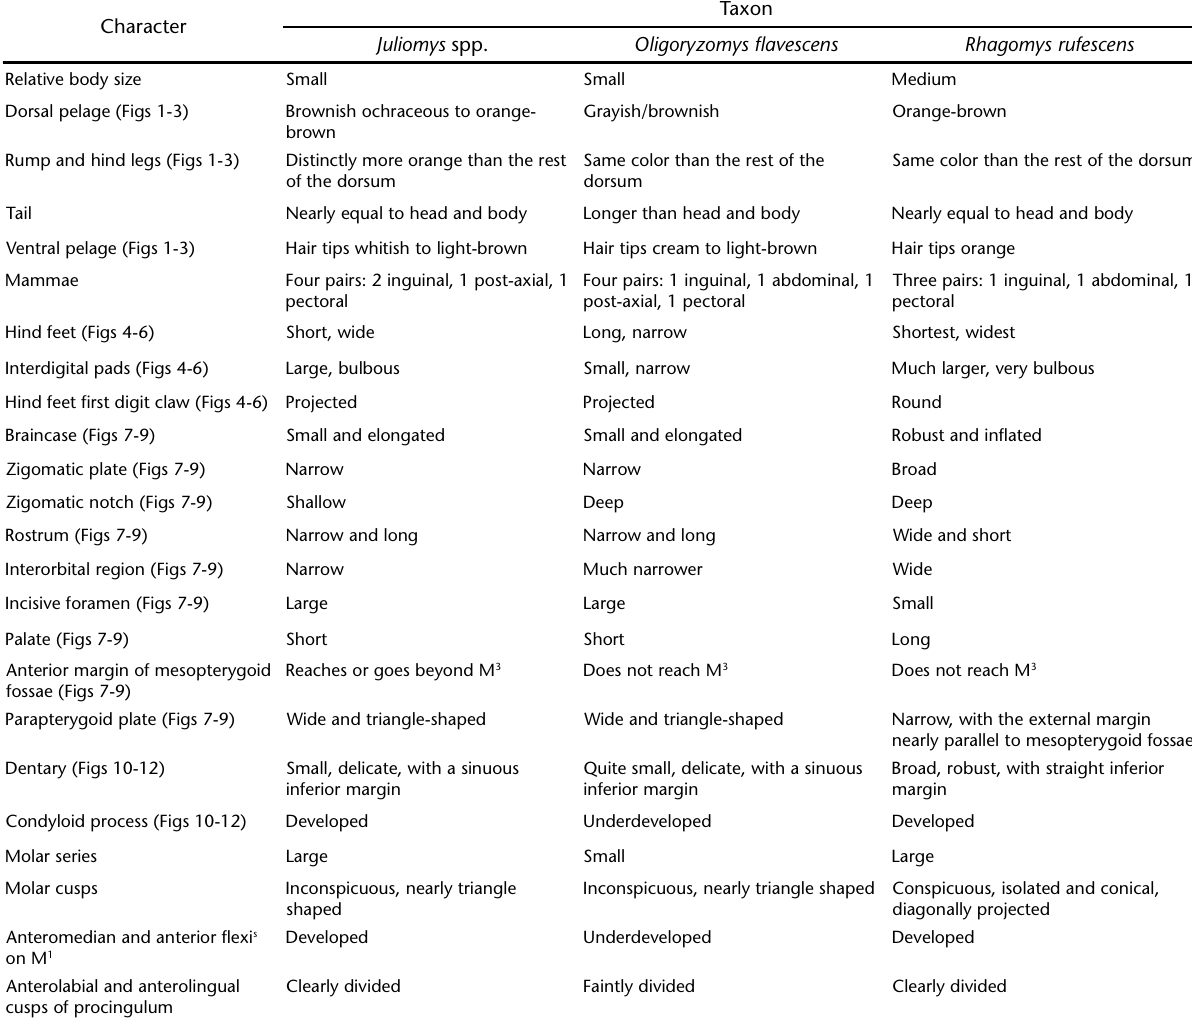
Table I. Selected comparative diagnostic characters of Juliomys spp., Oligoryzomys flavescens , and Rhagomys rufescens